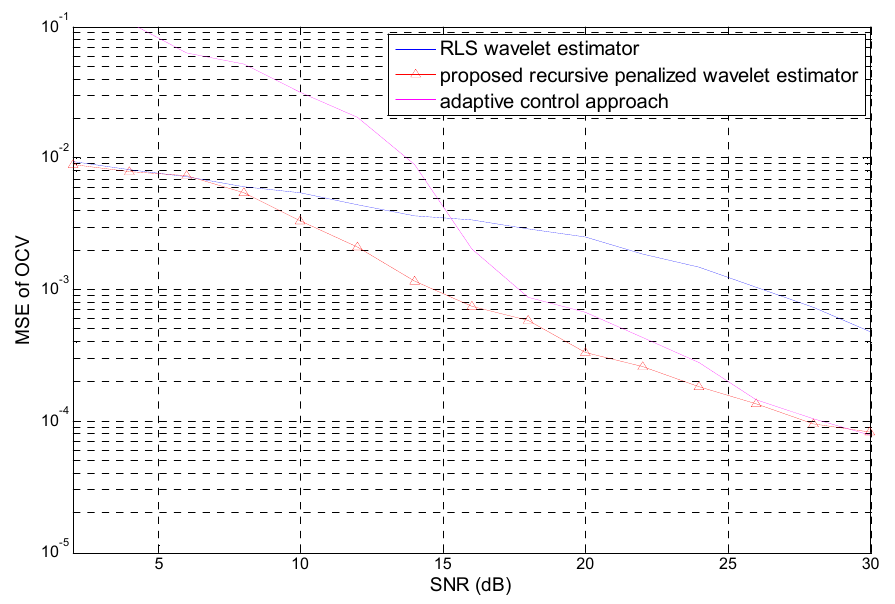
Figure 5. MSEs of OCV plotted against